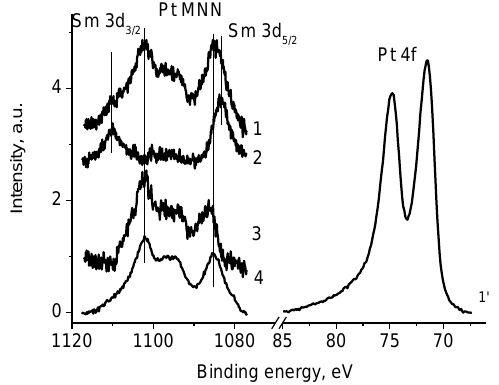
Figure 18. The Sm 3d photoelectron spectra of samples Pt/3 (1), 3 (2), their difference spectrum (3), Pt MNN Auger spectrum (4) and Pt 4f 7/2 (1’).